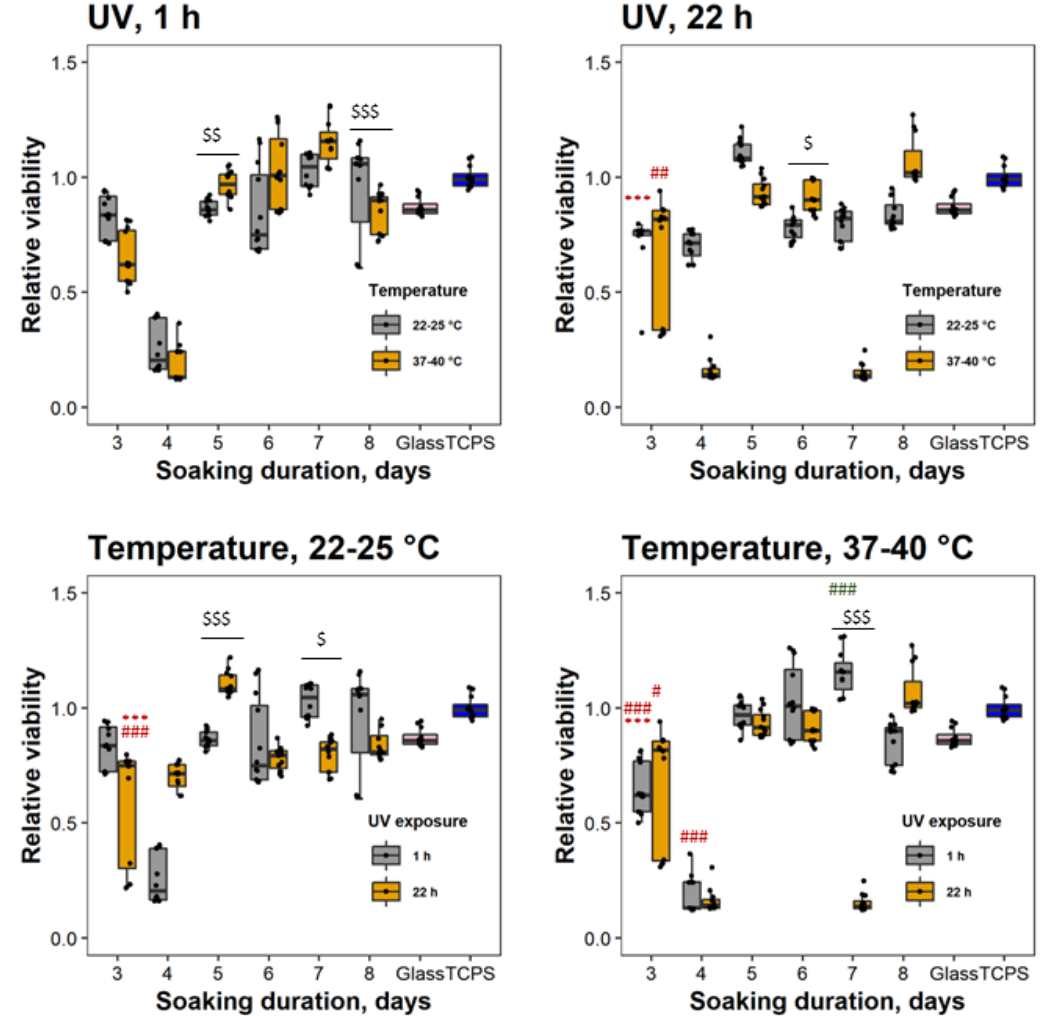
Figure 4. Biocompatibility test results. ( top ) The relative viability depending on soaking duration and temperature, when UV exposition was 1 and 22 h. ( bottom ) The relative viability depending on soaking duration and UV exposition, when temperature was 22–25 ◦ C and 37–40 ◦ C. *, # mark statistically significant changes then p < 0.05, ** p < 0.01, *** p < 0.001. * and # mark significant differences between tissue culture plate surface (TCPS) and glass surface, respectively. $ marks significant differences between samples processed under the same time point. Red signifies differences below 1 (control level, TCPS) and green differences above